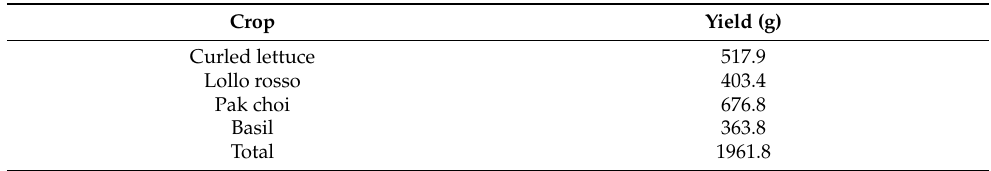
Table 7. Total yield of the crops investigated in this study.